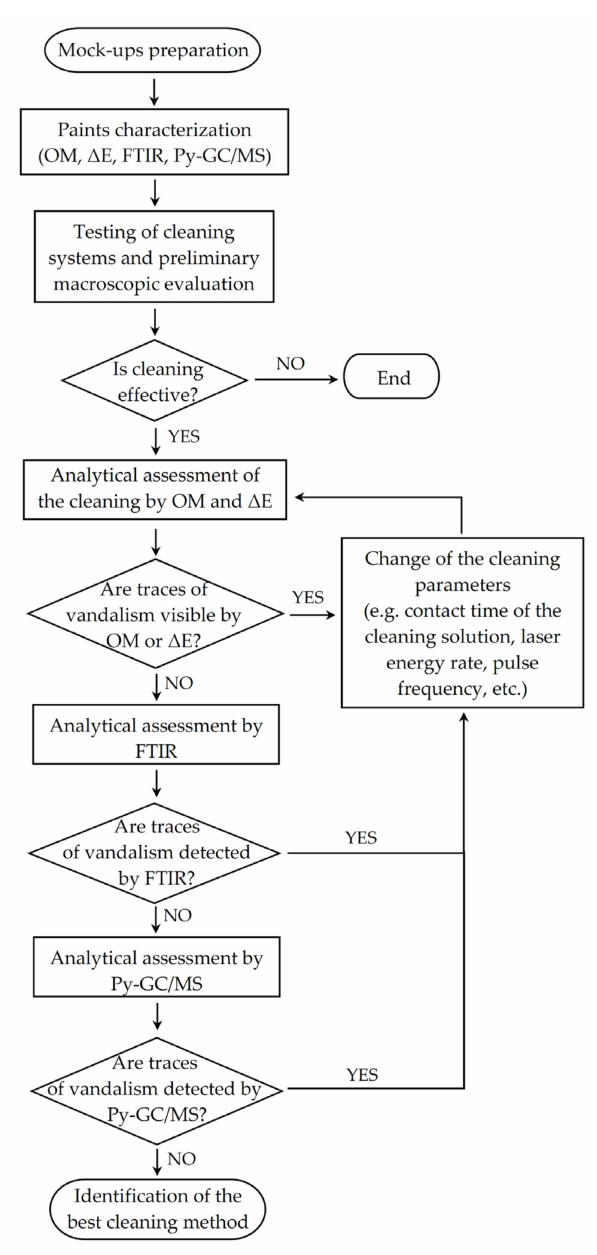
Figure 1. Flow chart of the experimental plan. OM: optical microscopy; ∆ E : colorimetric